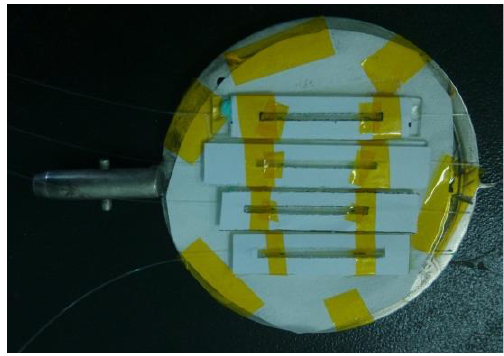
Figure 2. Arrangement of D-shaped FBGs on a sampling tray.